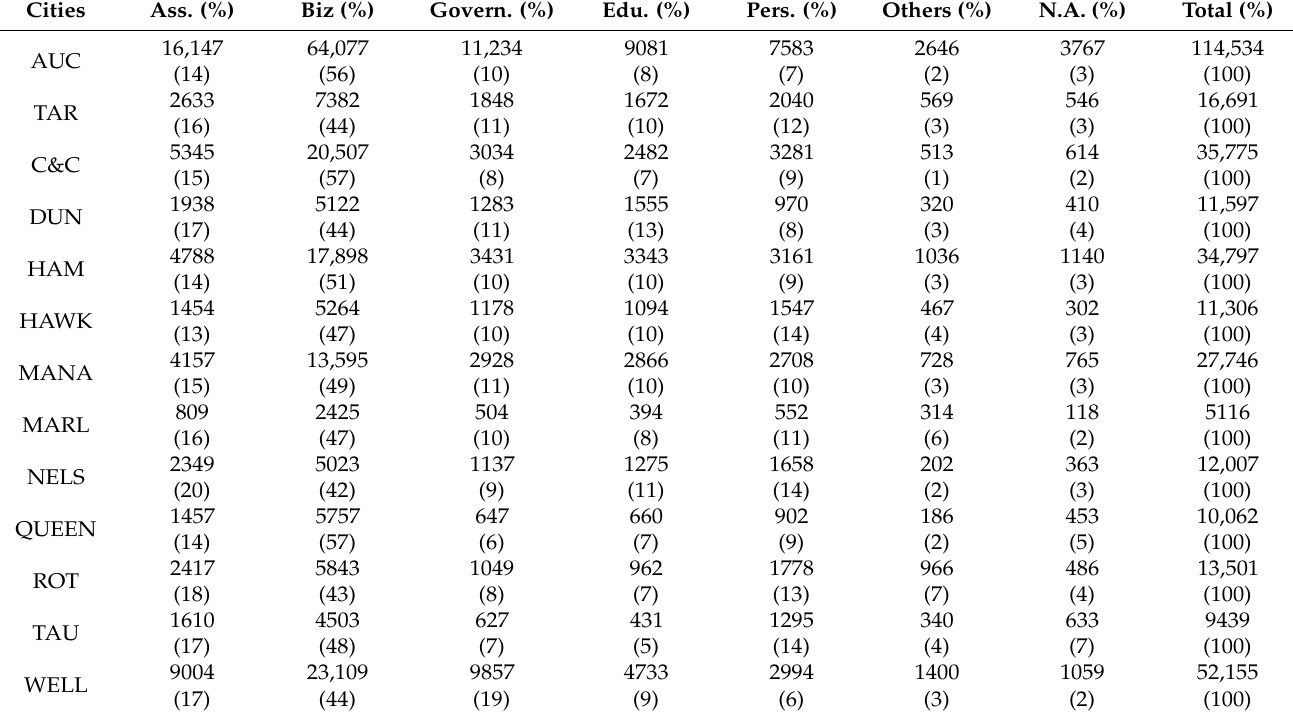
Table A2. Total volume by customer type dimension for eight years (2011–2018).